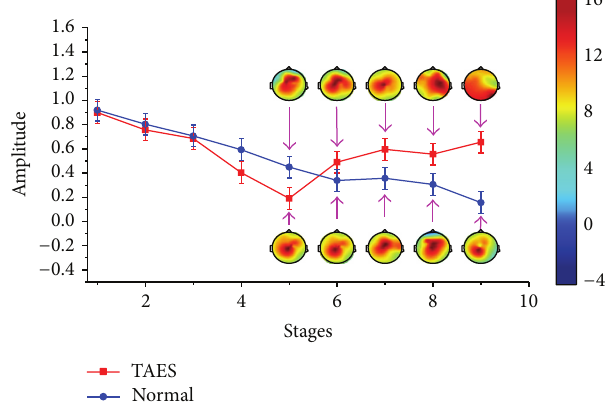
Figure 4: Relative power spectrum (mean ± S.D.) of 𝛽 subband for 9 stages of driving.